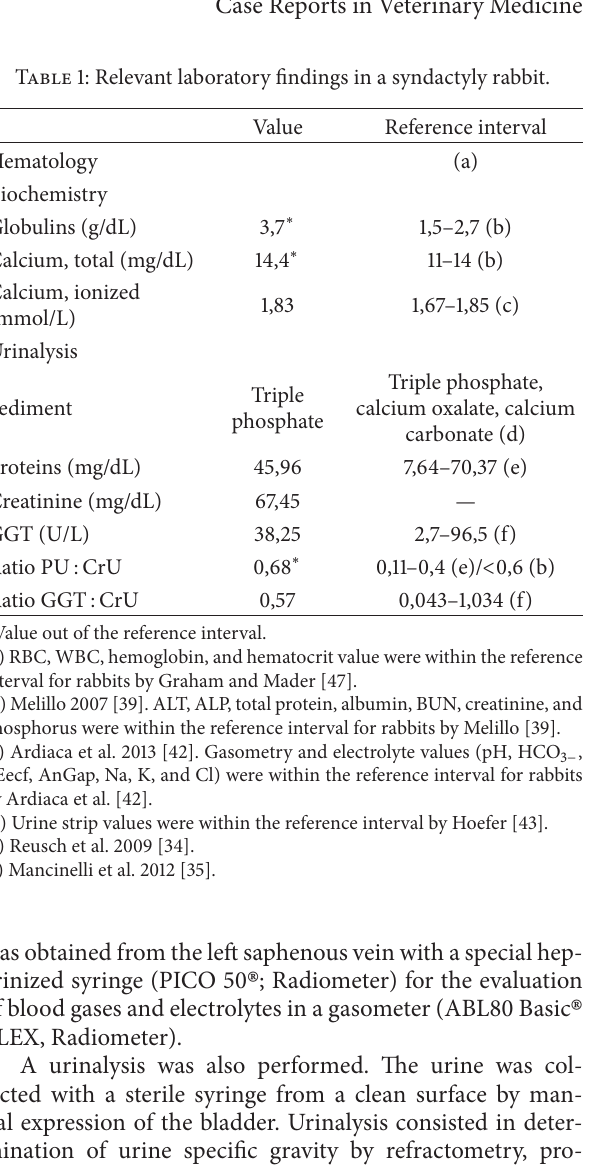
Table 1: Relevant laboratory findings in a syndactyly